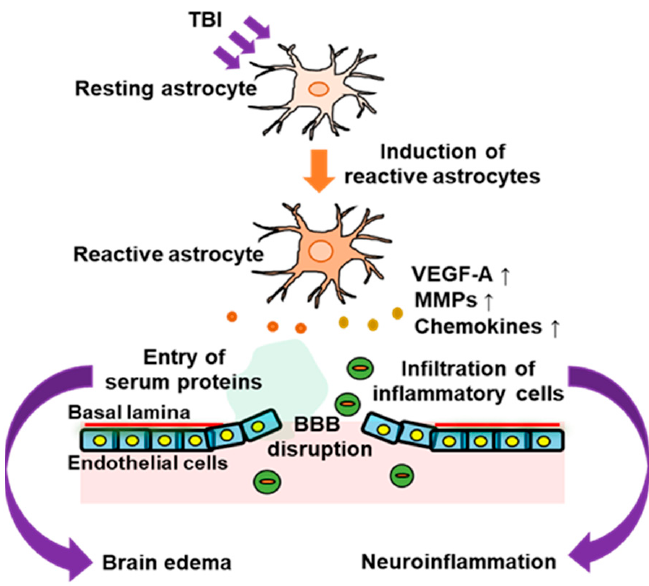
Figure 1. Involvement of astrocytes in BBB disruption in the acute phase of traumatic brain injury (TBI). In the acute phase of TBI, activation of astrocytes occurs around the damaged brain area. The astrocytic activation is accompanied by increased expressions of astrocyte-derived vascular perme- ability factors, such as vascular endothelial growth factor-A (VEGF-A), matrix metalloproteinase 9 (MMP9), and chemokines. This impairs the barrier function of the blood–brain barrier (BBB) and allows entry of inflammatory cells and serum proteins into the brain parenchyma, which leads to neuroinflammation and brain edema.